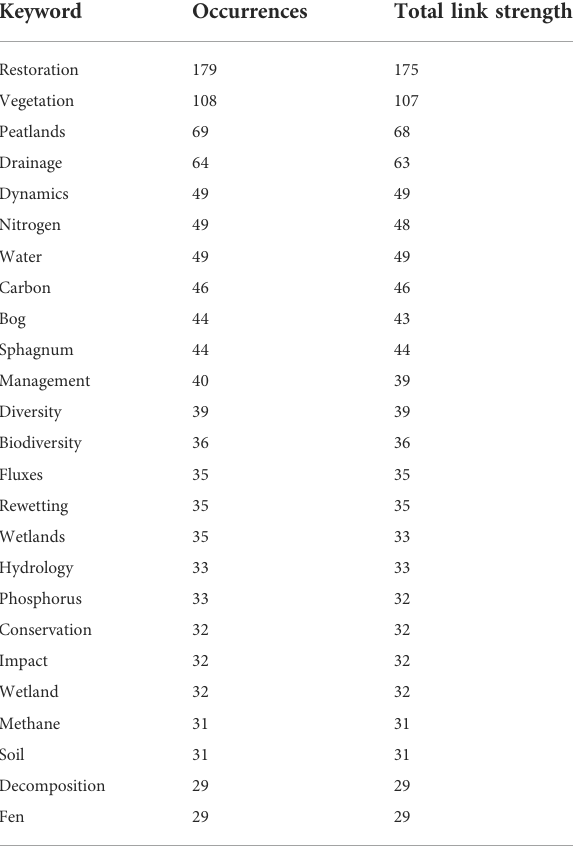
TABLE 2 Top 25 most active keywords in the restoration of degraded peatland